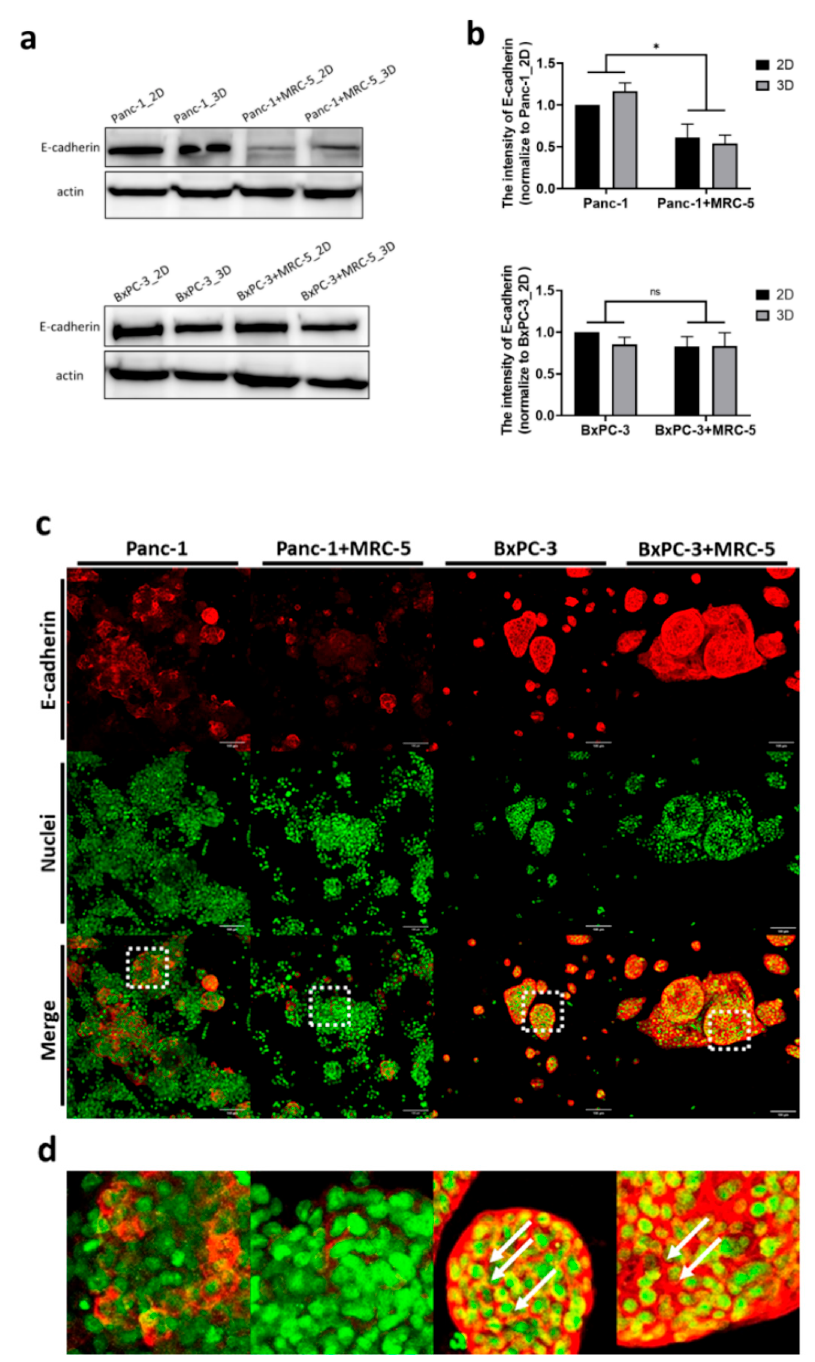
Figure 4. The expression of E-cadherin was upregulated in the 3D tumoroid structures and downregulated in Panc-1 when tumoroids were cocultured with fibroblasts. ( a ) The expression of E-cadherin determined by western blot assay and ( b ) the intensity quantified by ImageJ 1.53j software. ( c ) Immunofluorescence stained images of E-cadherin and Sytox (nuclei) in Panc-1 and BxPC-3 cancer cells grown alone or cocultured with MRC-5 after 7 days. The scale bar represents 100 µ m. (20 × Magnification) ( d ) The magnified confocal images of pancreatic tumoroids from ( c ). Statistical significance was determined by t -test. ns, non-significant; * p < 0.05.